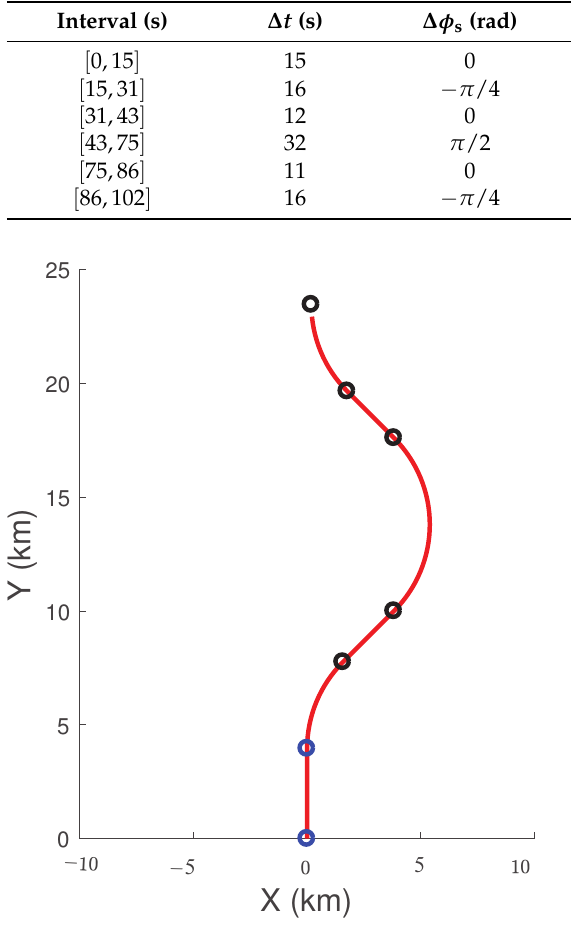
Figure 4. Sensor trajectory in the XY